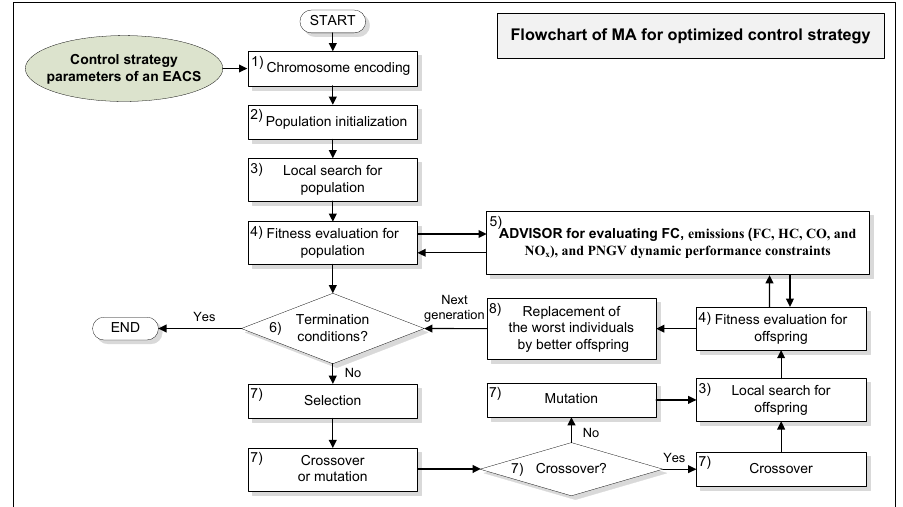
Figure 5. Flowchart of memetic algorithm (MA) for optimize control strategy.